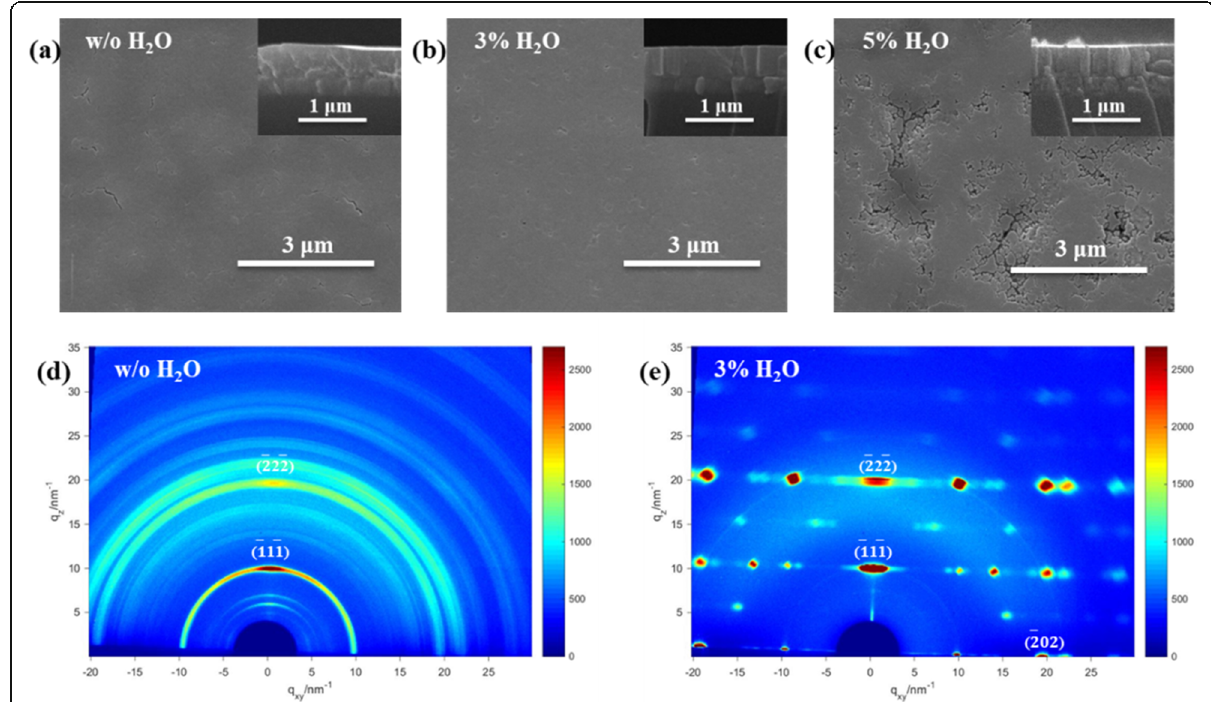
Fig. 3 a - c Top-view SEM images and cross-section SEM images (insets) of BA 2 MA 3 Pb 4 I 13 films with various amounts of H 2 O additive. GIWAXS patterns of